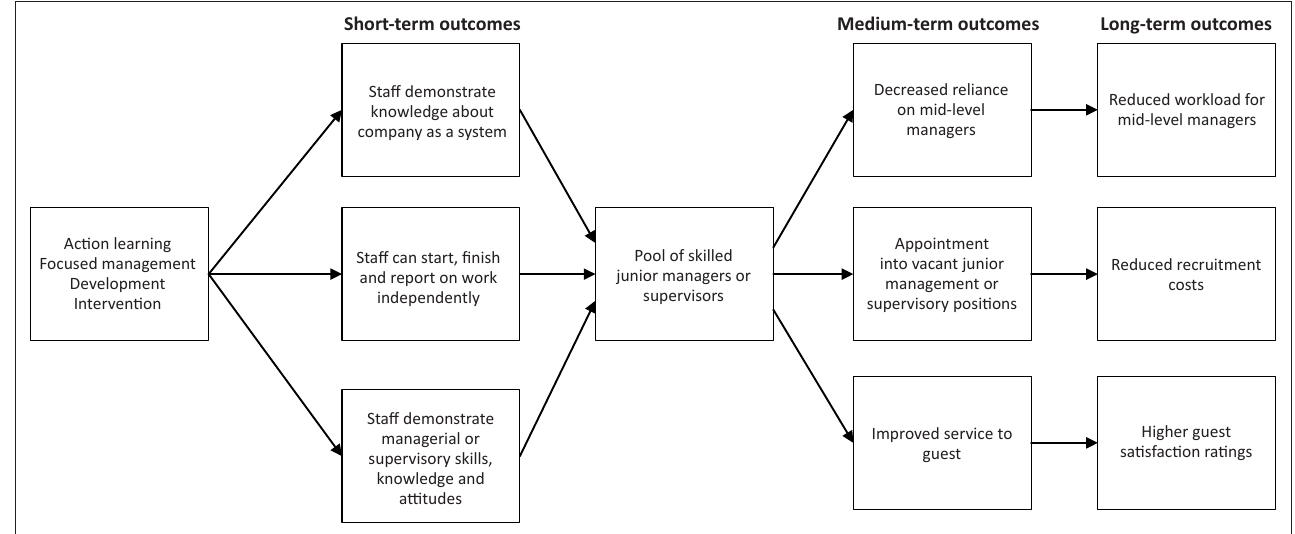
FIGURE 2: Impact theory of the supervisory development